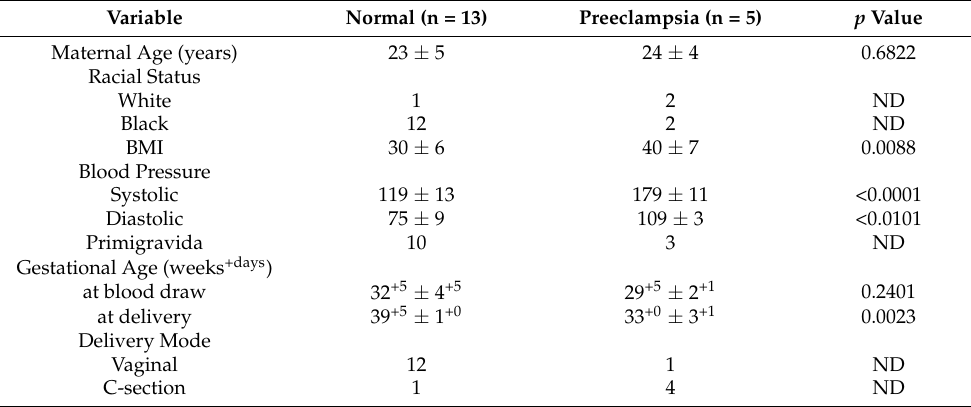
Table 1. Demographic data for maternal neutrophils used in the